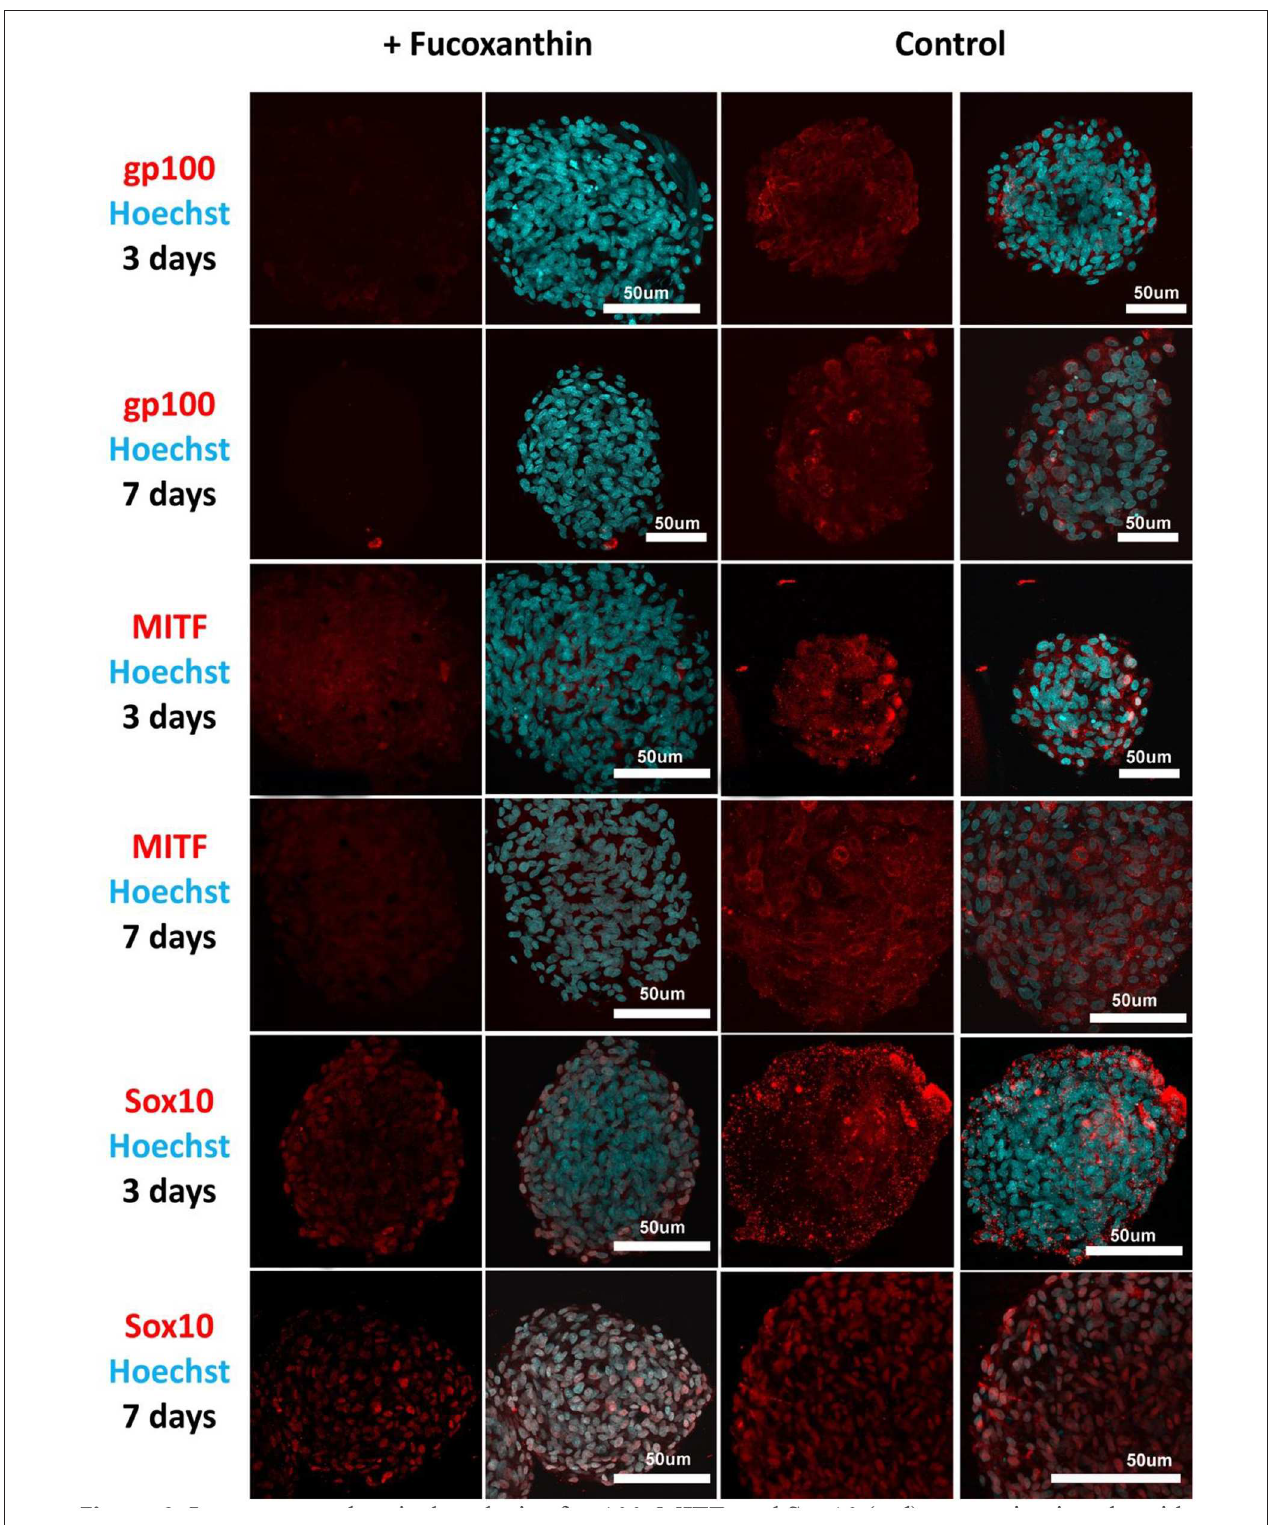
FIGURE 3 | Immunocytochemical analysis of gp100, MITF, and Sox10 (red) expression in spheroids from human melanocytes in the control and experimental groups on Days 3 and 7 in 3D culture. The nuclei are stained with Hoechst 33258 (blue). Laser-scanning confocal microscopy.